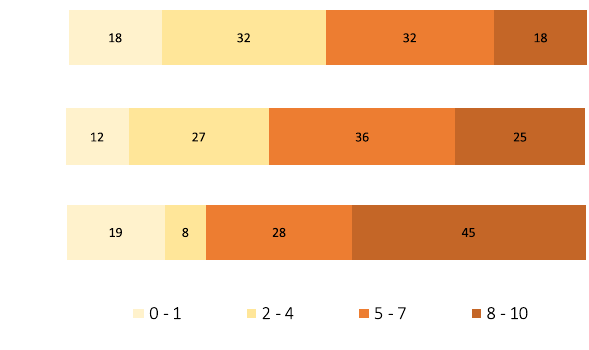
Figure 1. COVID-19 concerns of participants.